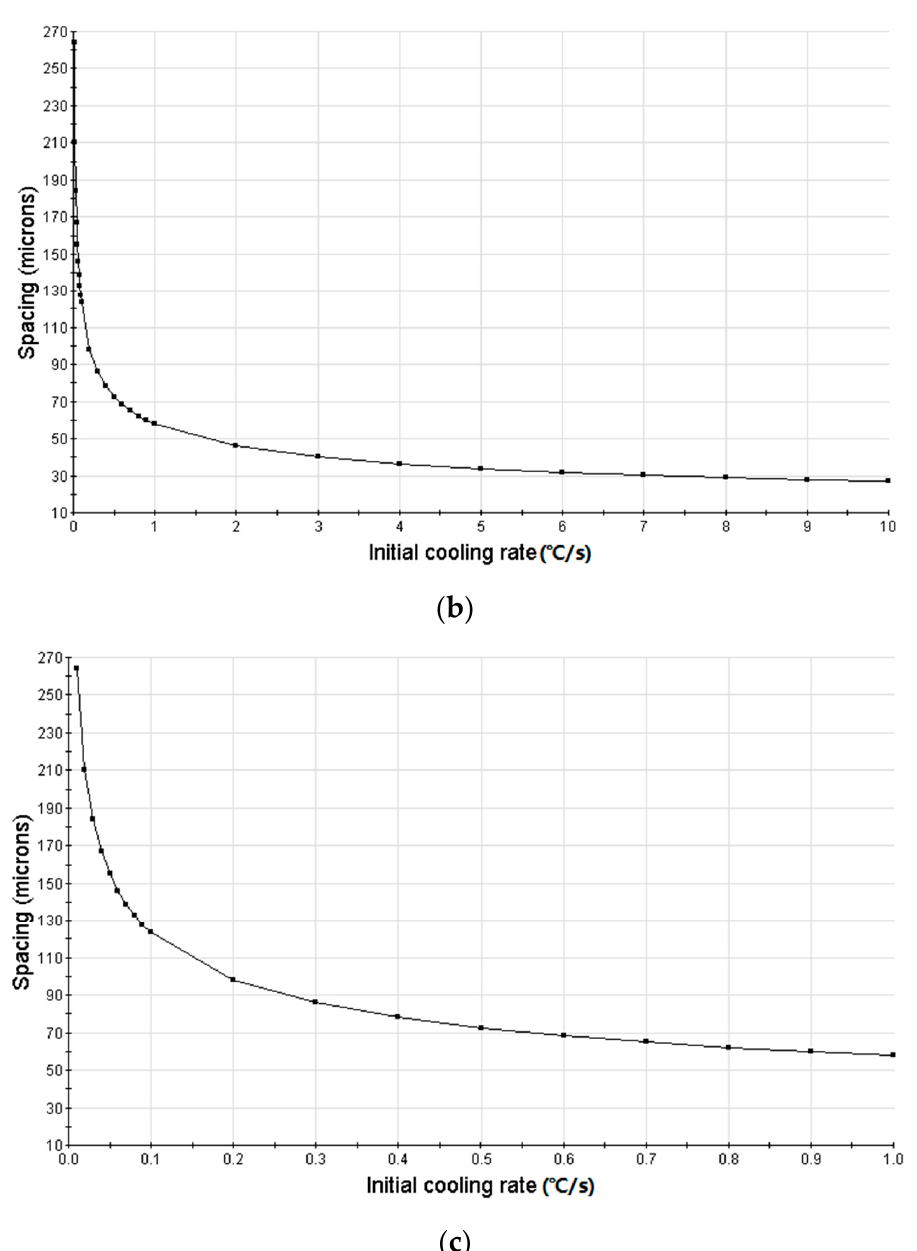
Figure 3. Result of analysis of solidification phases and properties: spacing (microns)–initial cooling rate ( °C /s): ( a ) initial cooling rate 100 °C /s; ( b ) initial cooling rate 10 °C /s; ( c ) initial cooling rate 1 °C /s.